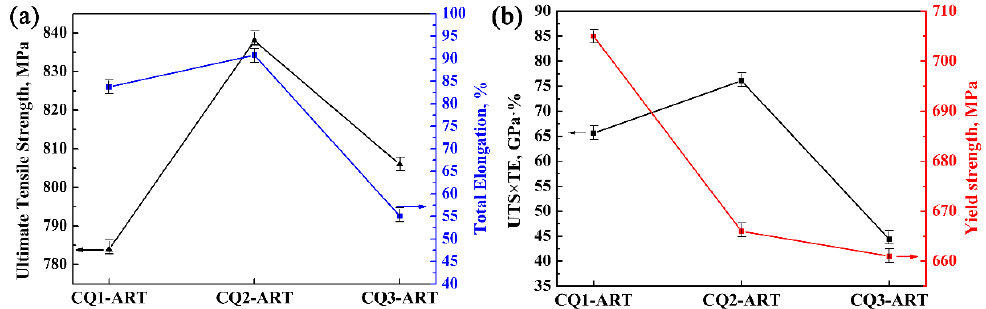
Figure 4. Tensile properties of experimental steel with different numbers of quenching cycles: ( a ) UTS and TE; ( b ) UTS × TE and YS (UTS: ultimate tensile strength, TE: total elongation, YS: yield strength).